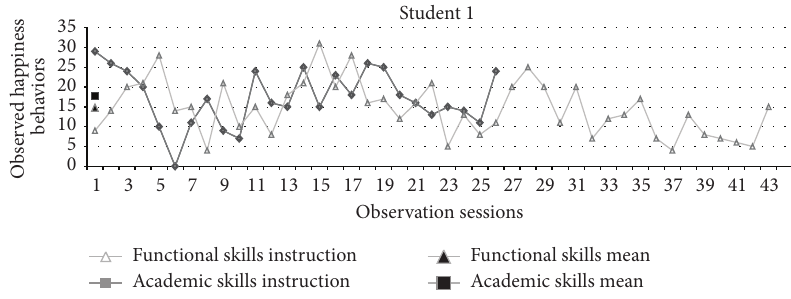
Figure 2: Total frequency of behaviors associated with happiness per observation session for Student 1.